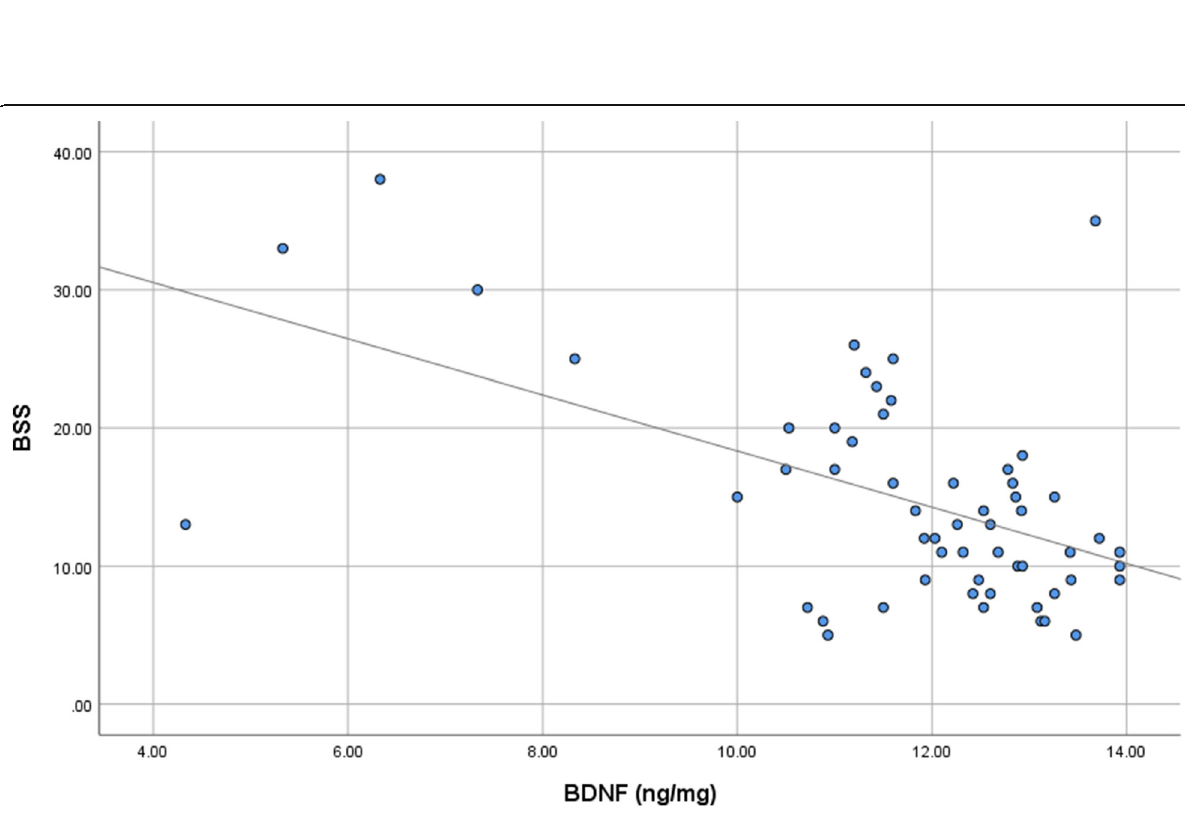
Fig. 3 Correlation between serum level of brain-derived neurotrophic factor (BDNF) and Beck Scale for Suicidal Ideation